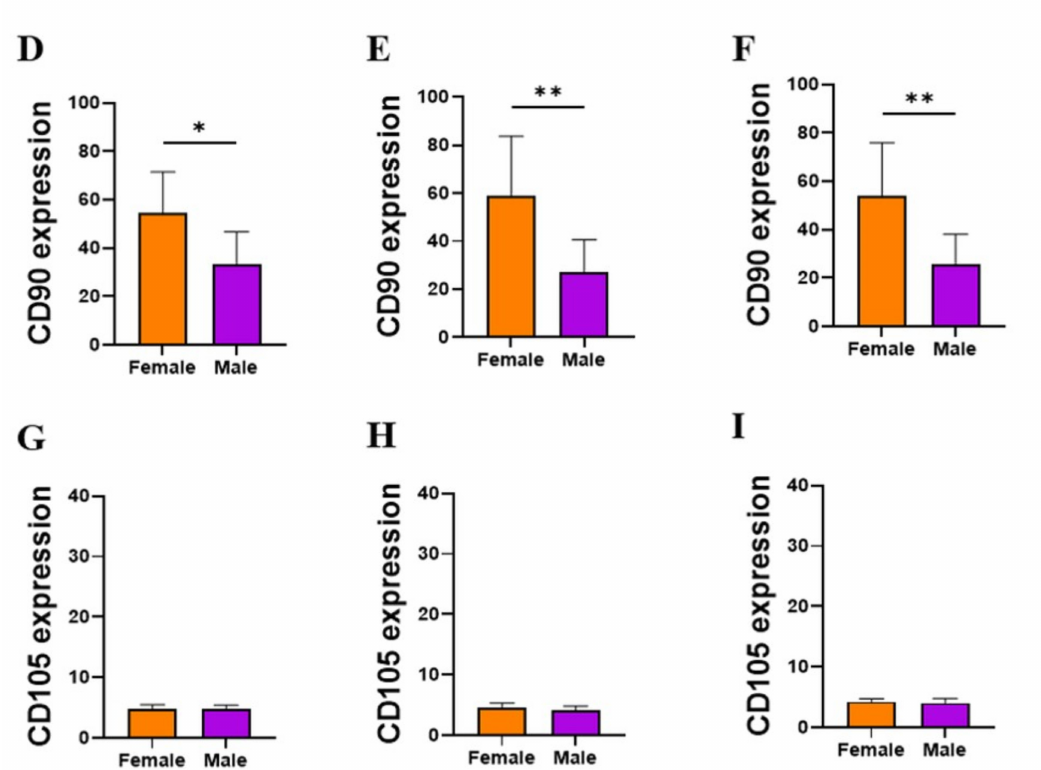
Figure 9. Expression of cell surface markers in SA–ASC. Differences between female and male patients in the expression of CD73 ( A – C ), CD90 ( D – F ) and CD105 ( G – I ) markers on SA–ASC from LA, MLA and SVF samples. The geometric mean fluorescence intensity (geo MFI) data are expressed as bars with SD of 8 patients. Statistical analysis was performed using unpaired t -test. p -values: (*) p < 0.05; (**) p < 0.01; (***) p < 0.001; (****) p <